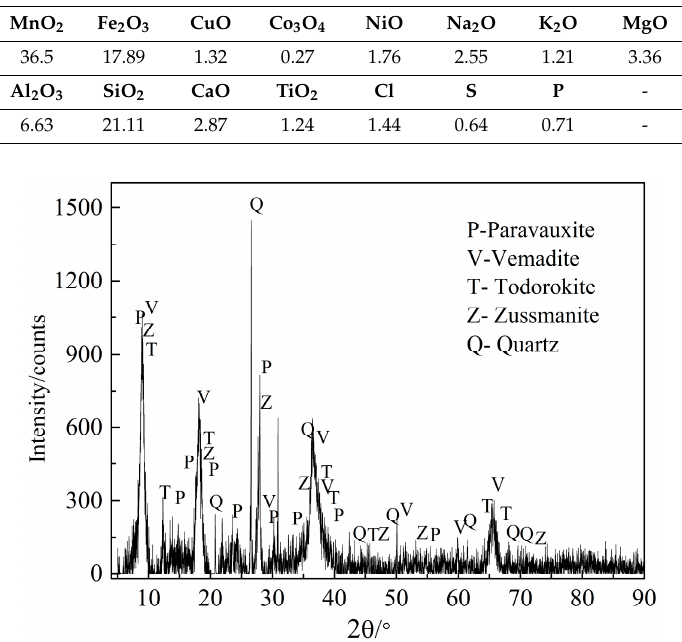
ff raction (XRD) pattern of ocean manganese Figure 1. X-ray diffraction (XRD) pattern of ocean manganese nodules. Figure 1. X-ray di